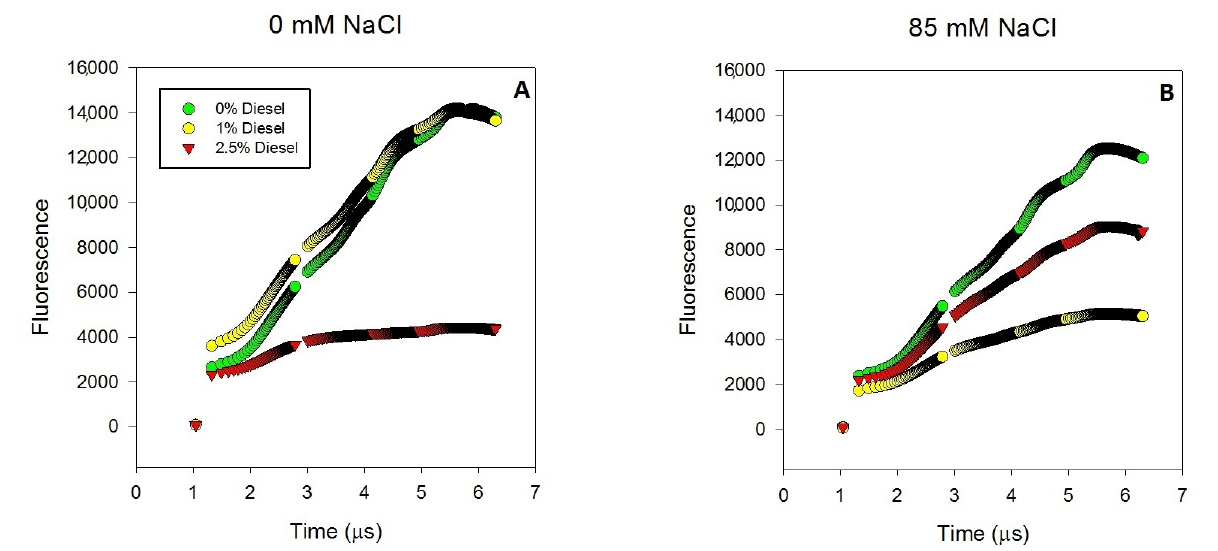
Figure 3. Transient fluorescence (Kautsky curves) of dark-adapted leaves of Juncus acutus in response to treatment with a range of diesel concentrations at 0 mM NaCl ( A ) and 85.5 mM NaCl ( B ) for 20 d. Values represent the mean of five measurements per treatment